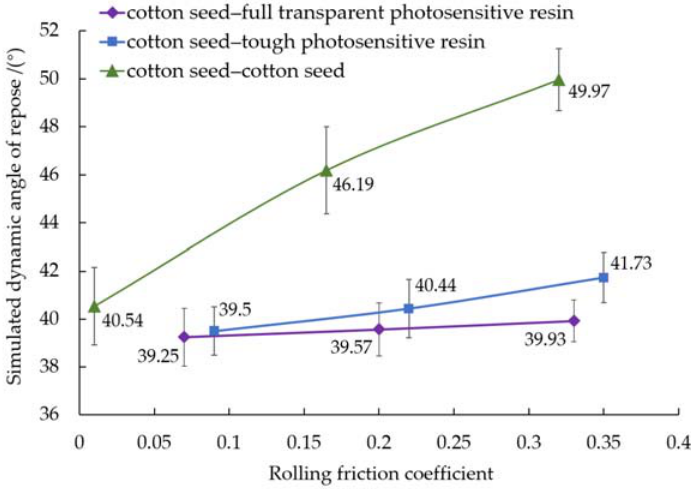
Figure 16. Effect of the rolling friction coefficient on simulated dynamic repose angle.